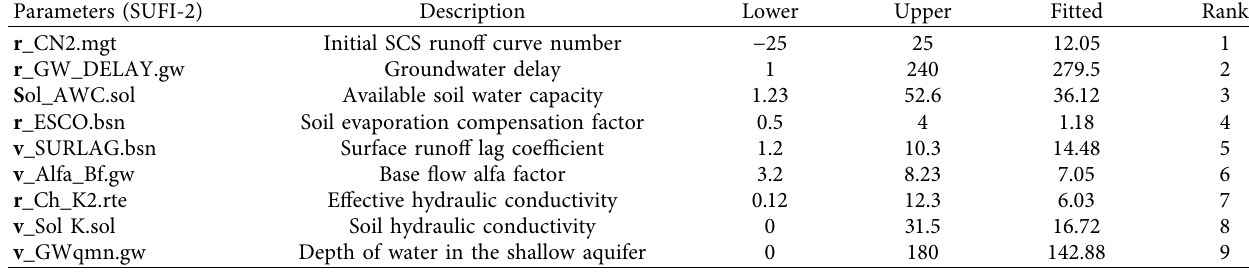
Table 5: Description of parameters used for calibration, fitted value, and its sensitivity rank.